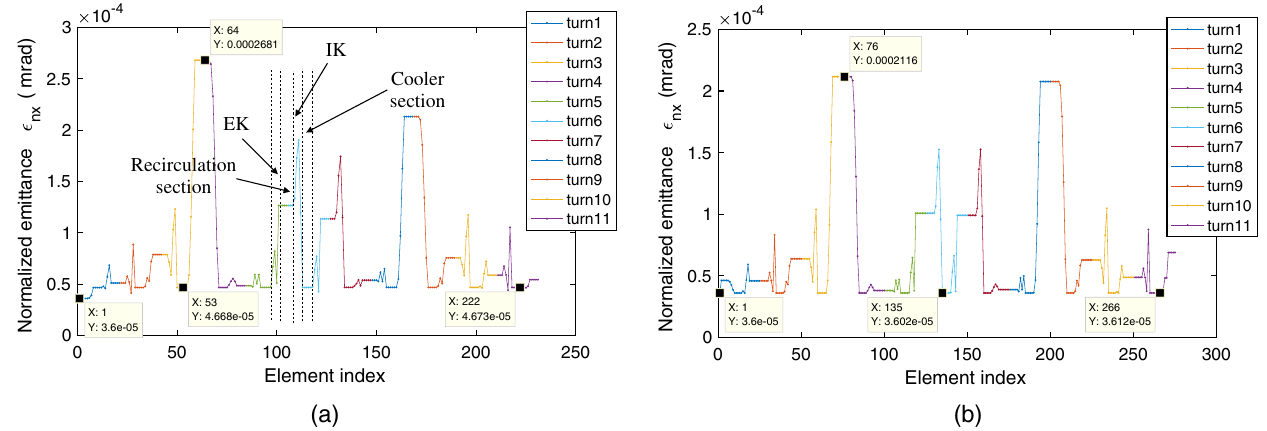
FIG. 6. The emittance growth through 11 turns in the CCR without (left) and with pre/postkickers (right). (a) Emittance change without pre/postkickers. x ¼ 1 is the in-kicker (entrance) position, x ¼ 8 is the cooler position, and x ¼ 11 is the out-kicker (entrance) position. (b) Emittance change with pre/postkickers. x ¼ 1 is in-kicker (entrance) position, x ¼ 11 is the cooler position, and x ¼ 13 is the out-kicker (entrance) position. The beamline in the simulation includes four extra elements per turn: pre/postkicker with the associated DC magnets, although they are turned off except for the first/last